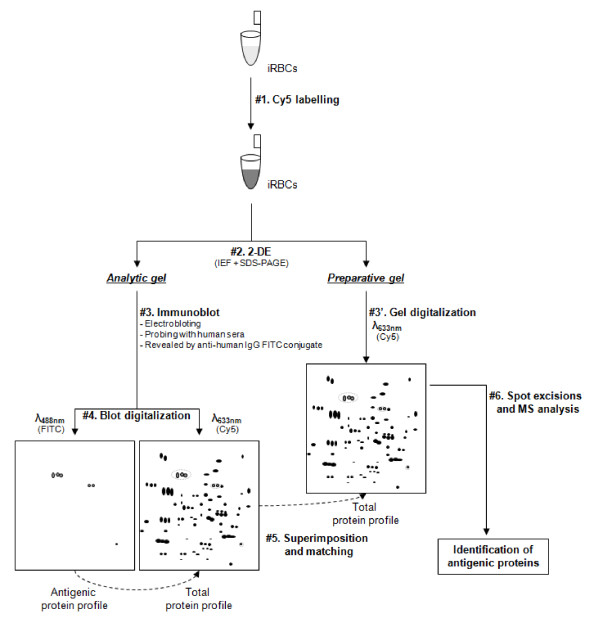
Schematic representation of experimental workflow for an accurate identification of antigenic protein using 2-D immunoblot with a fluorescence-based method. The different steps are numbered from #1 to #6. Briefly, iRBC membrane protein extracts were pre-labelled with Cy5 cyanine (#1), separated by 2-D electrophoresis (#2), electroblotted onto membranes, probed with the pool from 5 selected BEI sera and incubated with a goat-anti-human IgG FITC-conjugate (#3). Following blot digitalization at Cy5 and FITC wavelengths (#4), two images corresponding respectively to the antigenic protein pattern and the total protein expression profile were obtained. The superimposition of these two images (#5) allowed us to excize accurately spots of interest on preparative gel run in parallel (#3'), before to submit them to mass spectrometry (MS) for identification (#6). Protein expression profile was used as "internal standard" to perform a perfect match between the blot and the preparative gel.